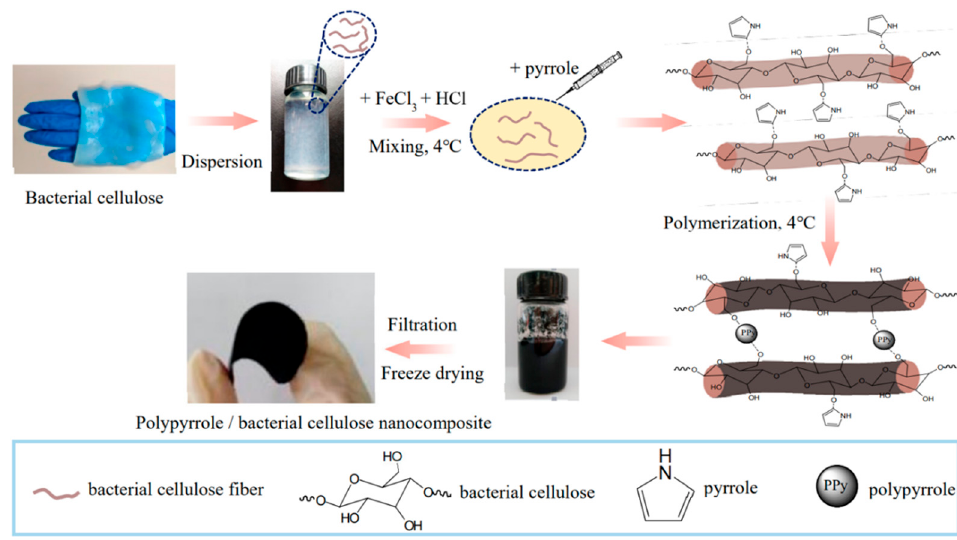
Figure 15. Schematic illustration of preparation PPY–BC nanocomposite. Reprinted with permission from [198]. Copyright 2019 MDPI.